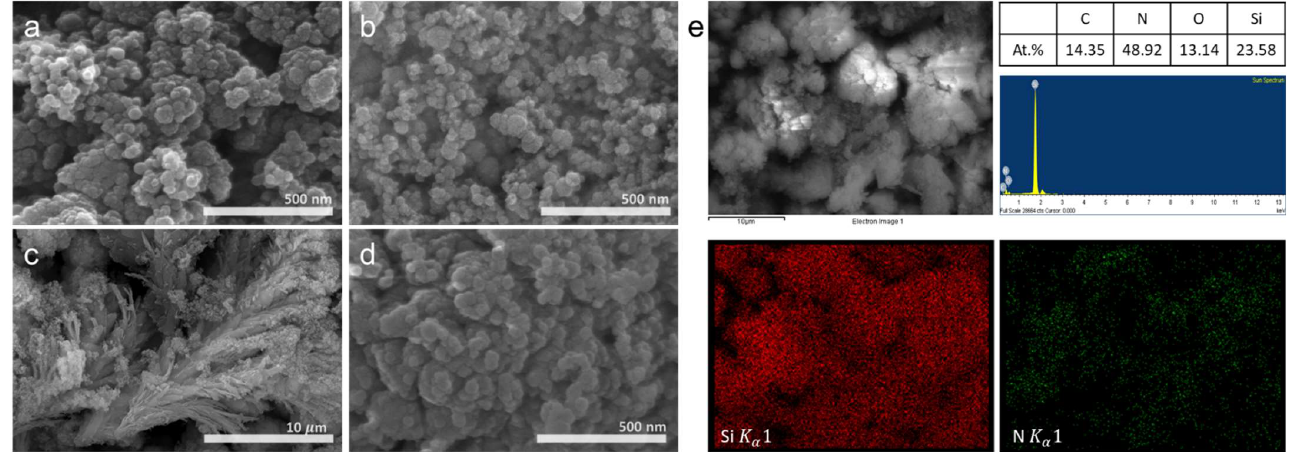
Figure 4. ( a – d ) Field emission (FE) Scanning electron microscopy (SEM) images of nanopowders synthesized in Runs 1–4, and ( e ) elemental mapping and composition of the nanopowder obtained in Run 3.